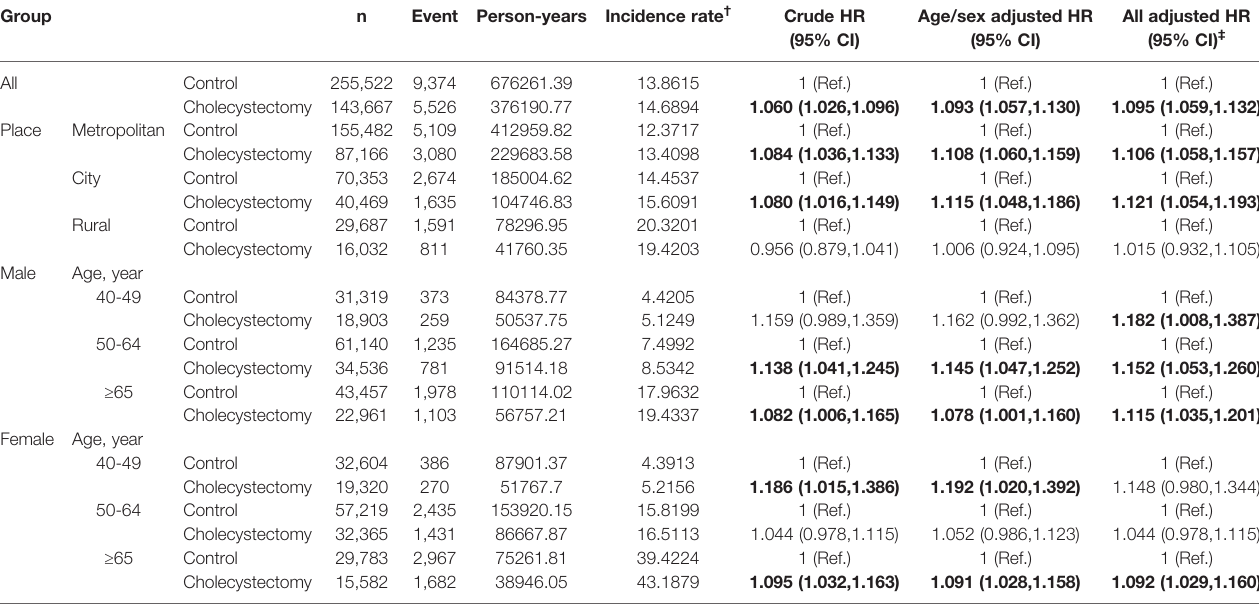
TABLE 3 | Incidence of all fractures in cholecystectomy group and control group according to age and sex subgroups. Group n Event Person-years Incidence rate † Crude HR